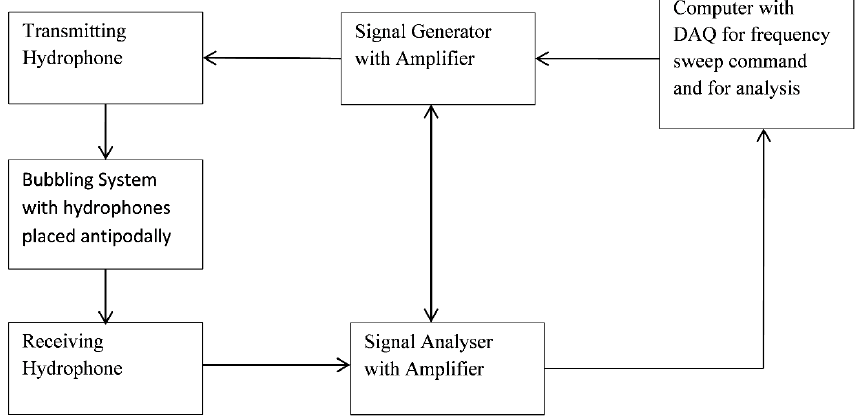
Figure 4. Information flow diagram of the Acoustic Bubble Spectrometer (ABS) and the hydrophone set up.